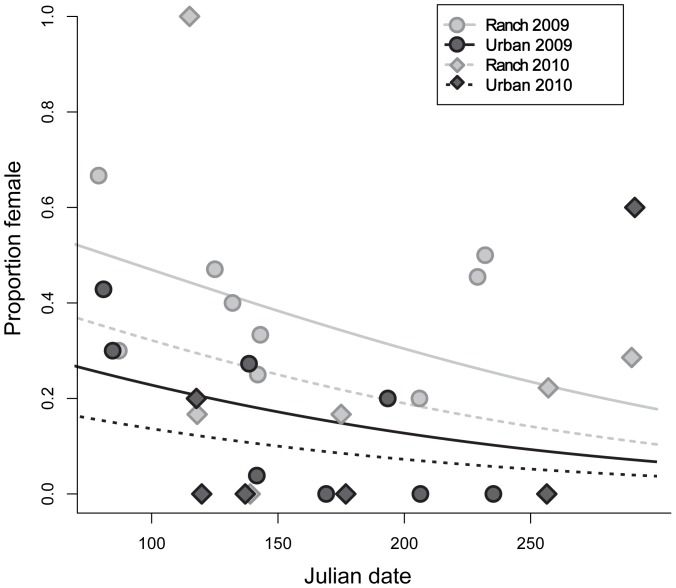
Sex ratio by site and year.Points indicate sex ratio (proportion female) of silversides collected at the ranch and urban beach in 2009 and 2010 on the indicated sampling dates. Curves are logistic regression fits.